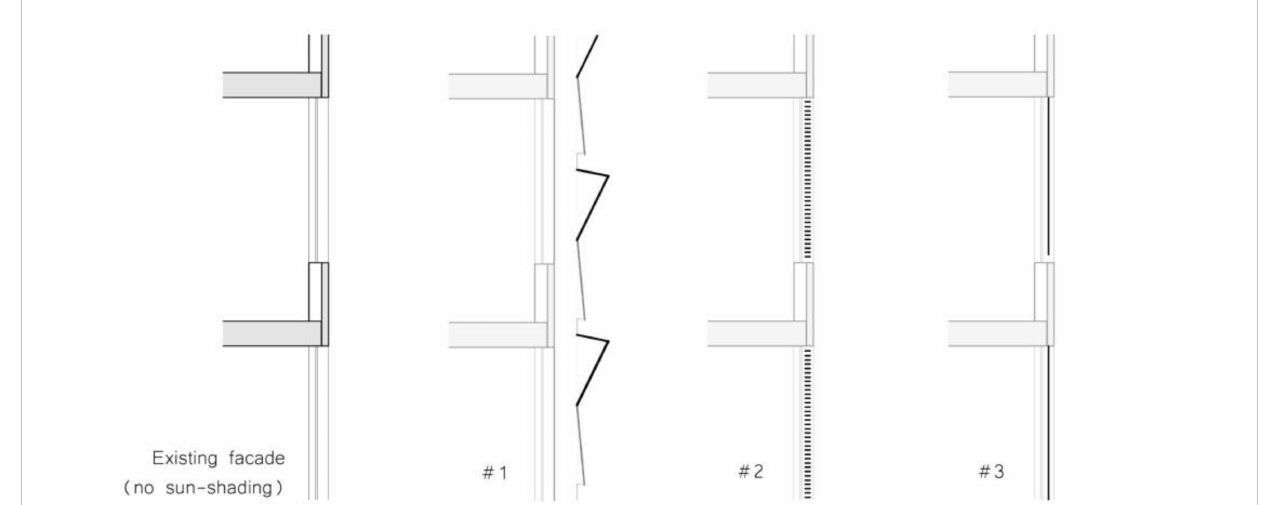
Figure 23. Overview of the cooling loads results for the shading type scenarios and compari- son to the existing single façade with no external sun-shading and the corresponding cases in schematic graphs.